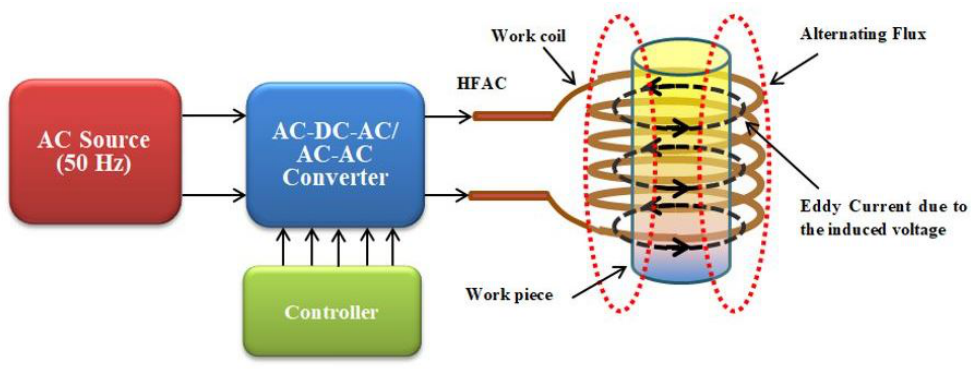
Figure 1. Typical IH system.